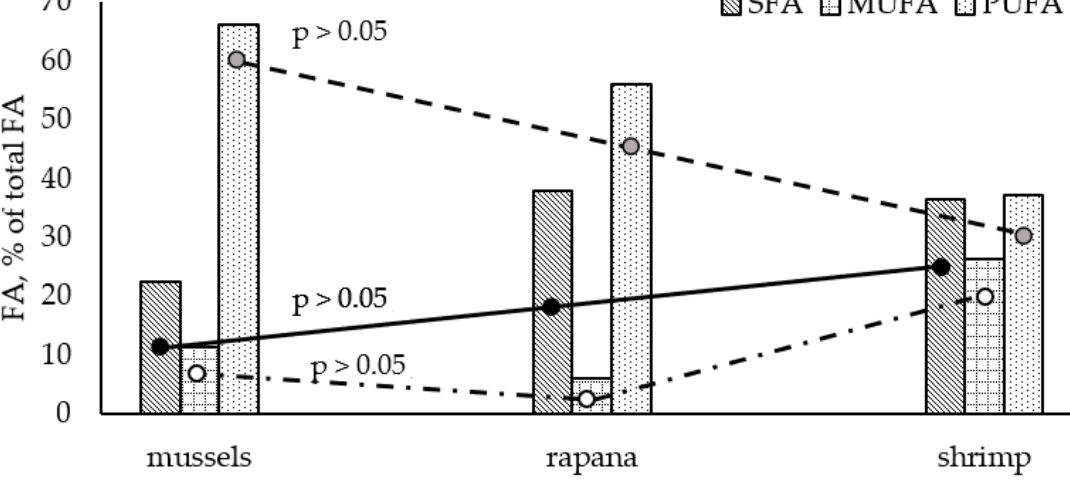
Figure 3. Differences in average fatty acid groups among the analyzed shellfish species. In our study, all shellfish presented significantly lower n-6/n-3 ratios and AI and TI indices and higher PUFA/SFA (up to 3.40 for C. gallina ) and h/H ratio (up to 4.67 for Ch. gallina ) compared to the studied fish species (Table 5). Observed results for all shellfish species for n-6/n-3, AI and TI were below 1.00, while the h/H index presented significantly higher than 1.00 levels with lowest the value calculated for C. crangon (1.52). Table 5. Nutritional quality indexes of 5 shellfish species from the Black